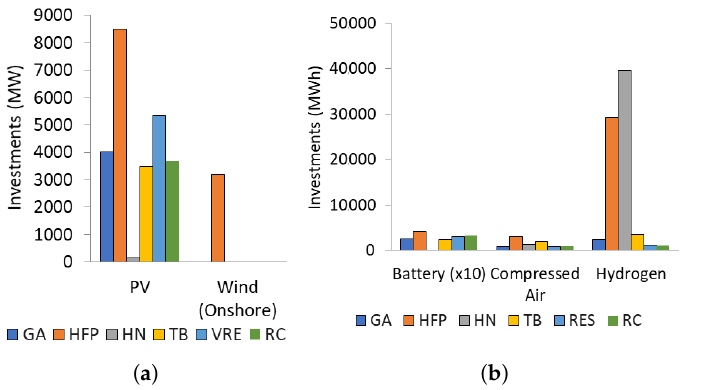
Figure 4. ( a ) 2030 investments in variable renewable generation. ( b ) 2030 investments in energy storage